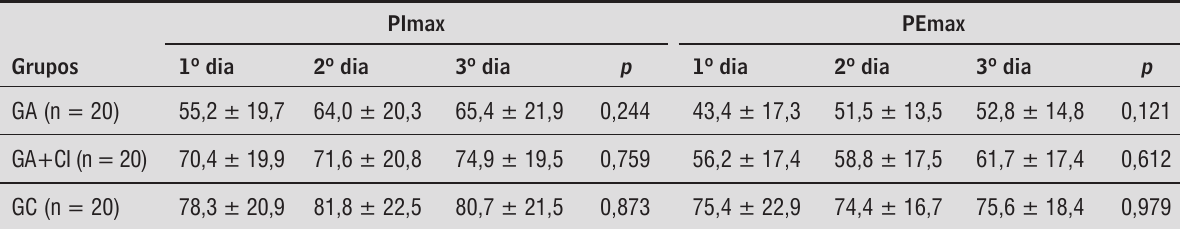
1. Beasley R. The global burden of asthma report. Global initiative for asthma. 2009. [access 11